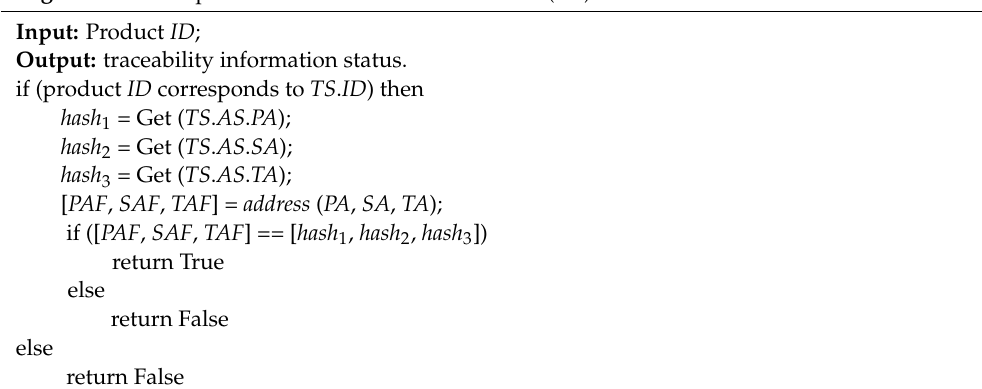
Algorithm 1: The platform authenticates the contract